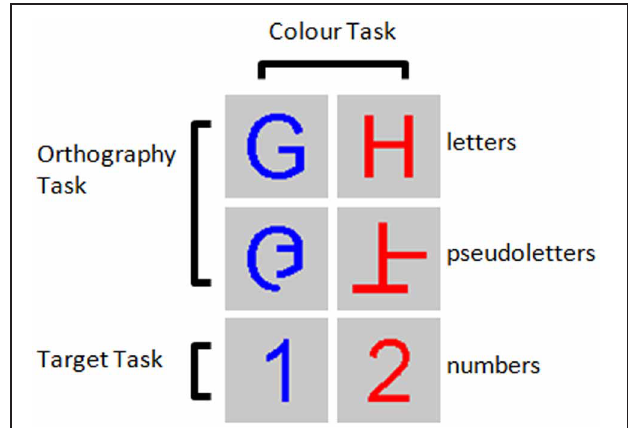
FIGURE 1 | Example stimuli for the three tasks performed. Participants were asked to detect numbers 1 and 2 presented among letters and pseudoletters for the Target task, to discriminate between letters and pseudoletters for the Orthography task, to discriminate between red and blue colored stimuli for the Color